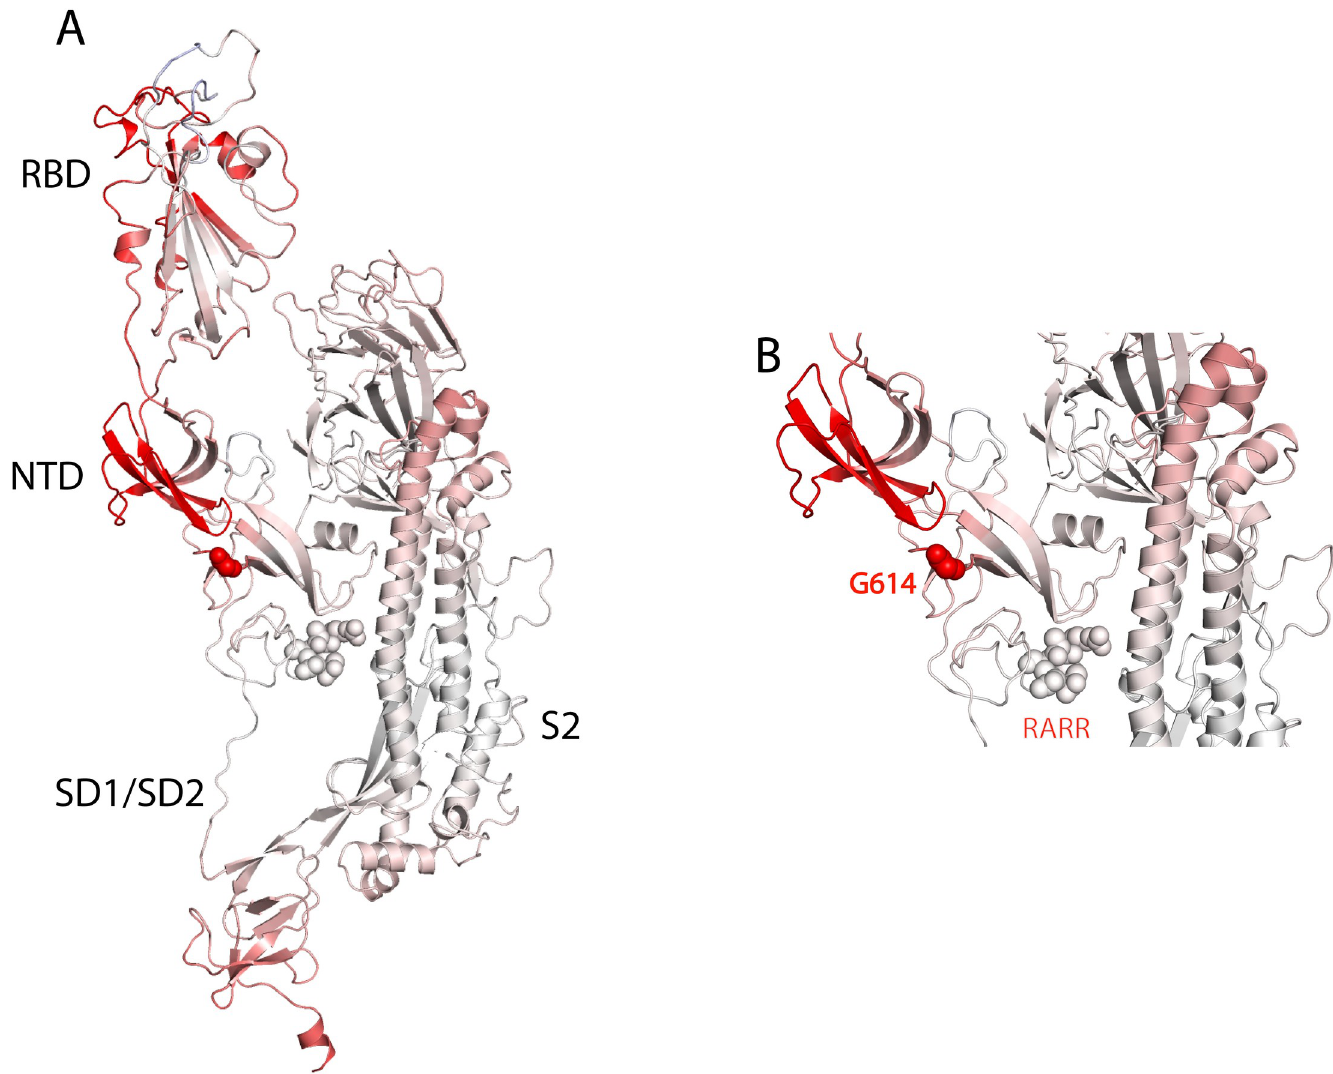
Fig 8. 3D modelling of G614 mutation. (A) S protein monomer 6VSB with D614G mutation, the red region of the protein depicts the more flexible region of the protein due to the D614G mutation with a decrease in stability of ΔΔ G: -0.086 kcal/mol and an increase in vibrational entropy to ΔΔ SVib 0.137 kcal.mol -1 .K -1 . (B) A zoomed-in structure of the N-terminal domain (NTD) and the G614 mutation in close vicinity to the RARR furin cleavage site.